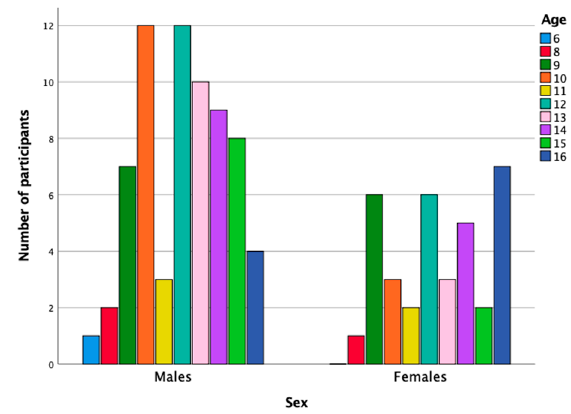
Figure 1. Sample